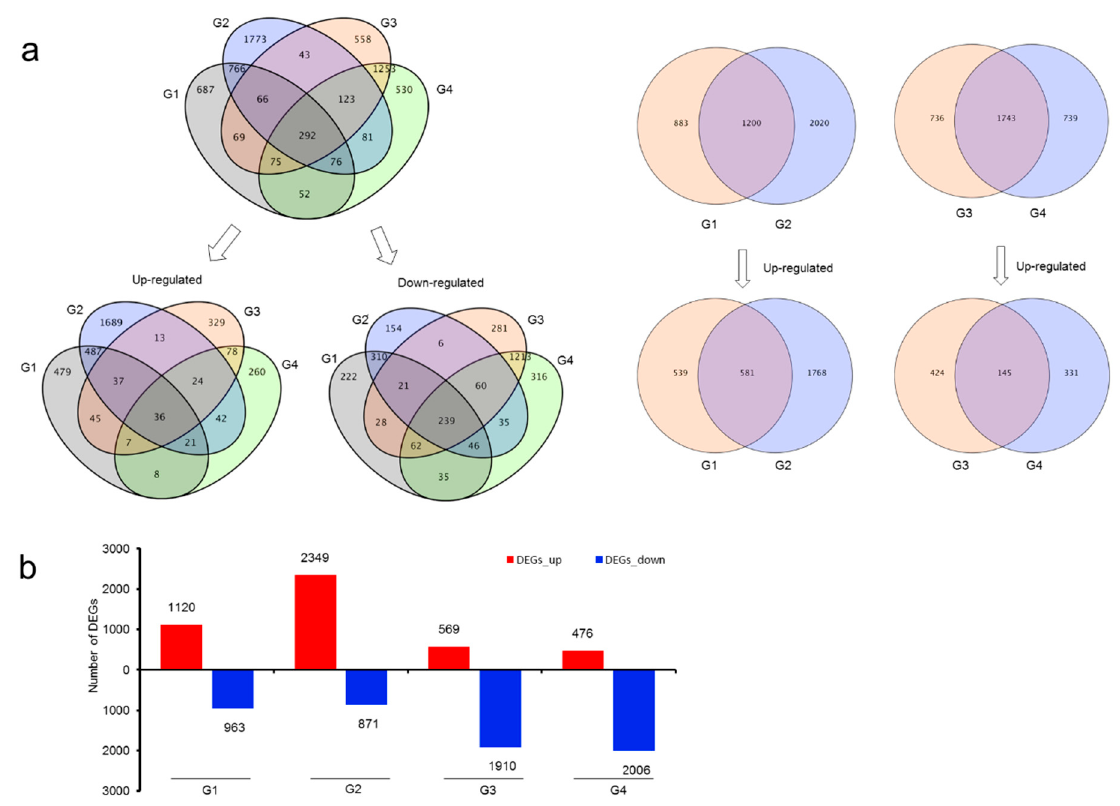
Figure 3. Differentially expressed genes in root and rhizome. ( a ) Venn diagram of DEGs in root and rhizome between drought and control group. ( b ) Up-regulated and down-regulated DEGs in root and rhizome. Abbreviation G1 (R h-0_vs._Rh-15), G2 (Rh-0_vs._Rh-30), G3 (Ro-0_vs._Ro-15), G4 (Ro-0_vs._Ro-30).